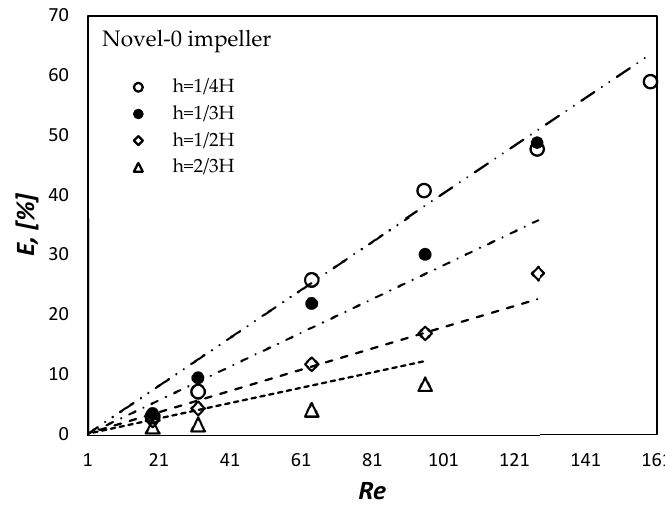
Figure 11. The mixing efficiency evaluated from experimental measurement for the Novel-0 impeller and different distances from the tank bottom.